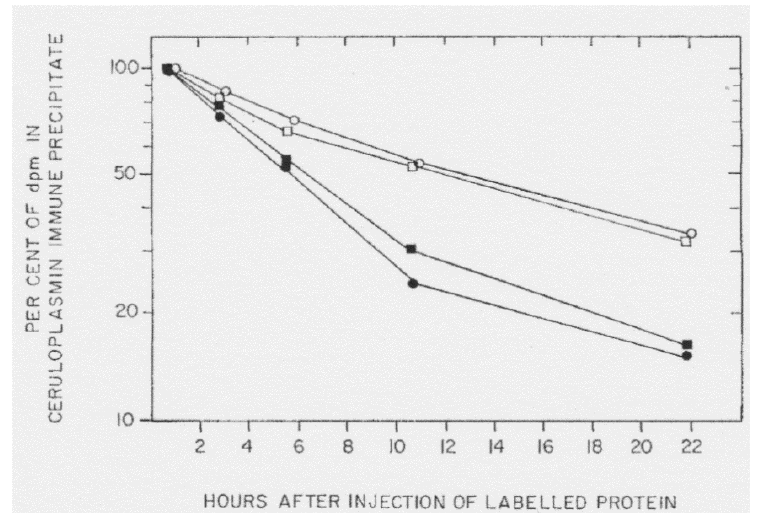
Figure 9. Rates of removal of apo and holo ceruloplasmin from the circulation of copper-deficient rats, after intravenous injection of radiolabeled ceruloplasmins that were relatively rich and relatively poor in the apo form. The 3 H-ceruloplasmin isolated from a copper-deficient rat (rich in apo ceruloplasmin) was infused intravenously into two copper-deficient rats (dark square and circle), and 3 H-radioactivity in immunoprecipitates of the plasma samples was measured at different times thereafter. The 14 C-labeled ceruloplasmin isolated from normal rats was infused into the same kinds of copper ‐ deficient rats, for comparison (clear squares and circles). Reprinted with permission from Holtzman and Gaumnitz [53].